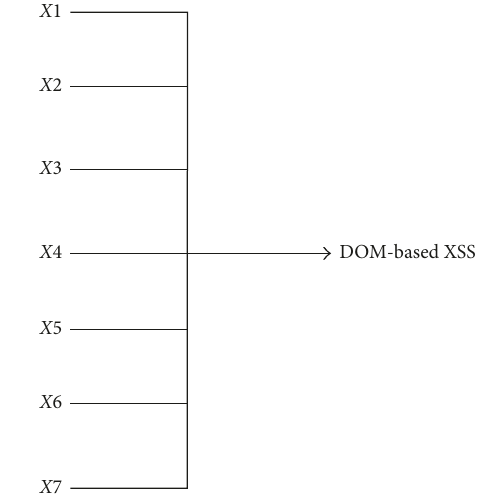
Figure 3: Locations vulnerable to DOM-based XSS